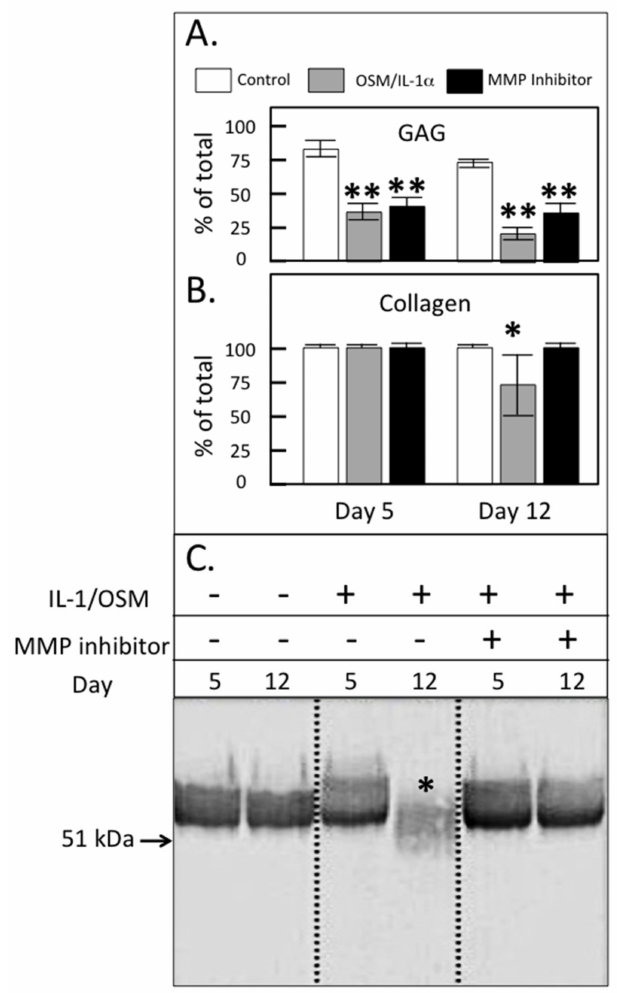
Figure 6. Glycosaminoglycan (GAG; A ) and collagen content ( B ) of ovine articular cartilage explants after 5 or 12 days of culture in Dulbecco’s Modified Eagles Medium (DMEM) without (control) or with 5 ng/mL IL-1 and 50 ng/mL oncostatin M (IL-1/OSM) ± 300 nM MMP-inhibitor PGE3162689 (expressed as % of the total in explant plus media; mean ± standard deviation) ( n = 6). Significant differences between control and treated cultures were defined as * p < 0.05, ** p < 0.01. ( C ) Western blot analysis of the FMOD core protein and the fragments in the cartilage extracts using PR-184, recognizing the C-terminus of FMOD. This blot was repeated three